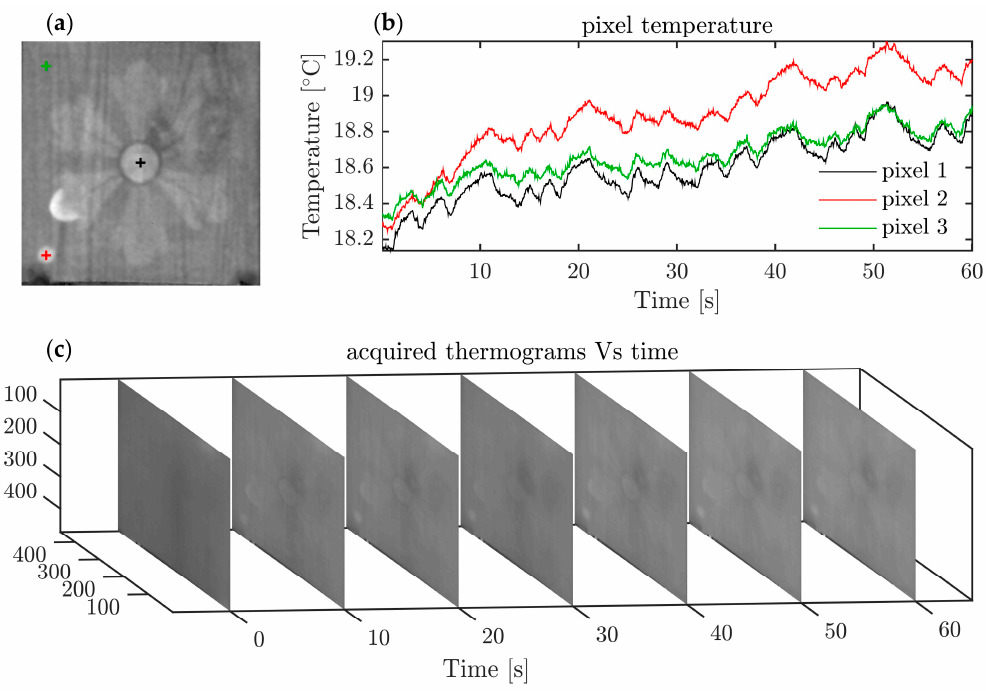
Figure 4. Raw experimental data collected with FLIR T660, i.e. setup (a) in Figure 3: ( a ) raw image of the sample under test (SUT) with three pixels marked on it; ( b ) marked pixels’ raw acquired temperature trends over the whole excitation time: even in the case of pixel 2, in correspondence to a defect, the maximum ∆ T of 1 ◦ C was achieved in 62 s of excitation, whereas for a sound pixel it was generally less than 1 ◦ C; ( c ) selected raw thermograms during the whole acquisition time: even if some defects are visible, the SNR is low.